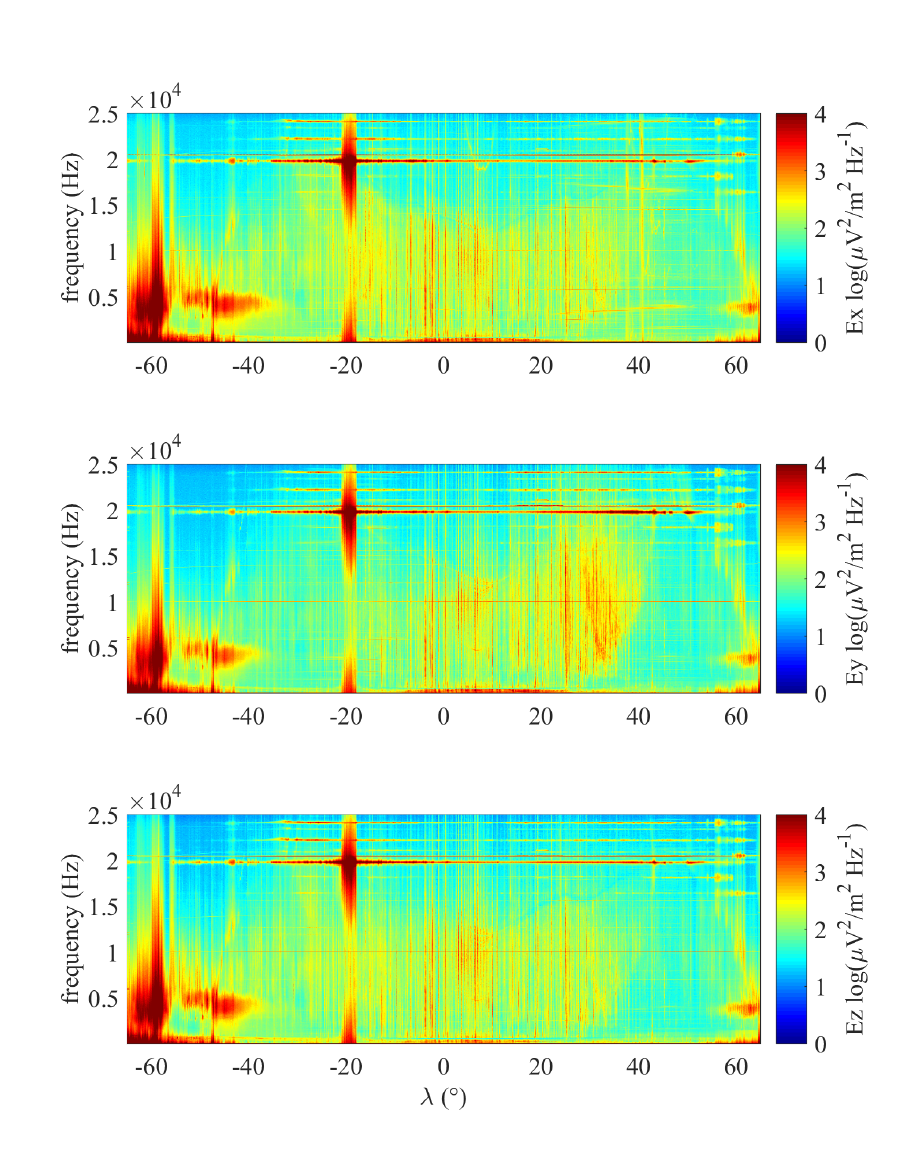
Figure 8. Spectrogram of the electric field components along the geographic North (upper panel), East (middle panel) and vertical (lower panel) directions recorded on 2 February 2019 between 18:27 UT and 19:02 UT. X-axis reports the geographic